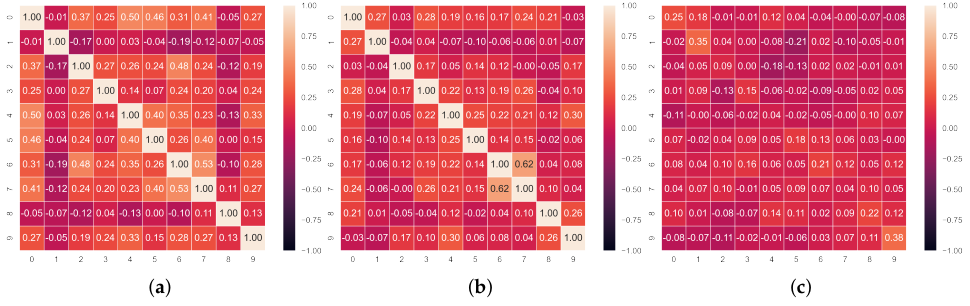
Figure 3. Correlation matrices between the honest and/or faked items in the CC dataset. ( a ) Correla- tion matrix of faked responses. ( b ) Correlation matrix of honest responses. ( c ) Correlation matrix of honest and faked